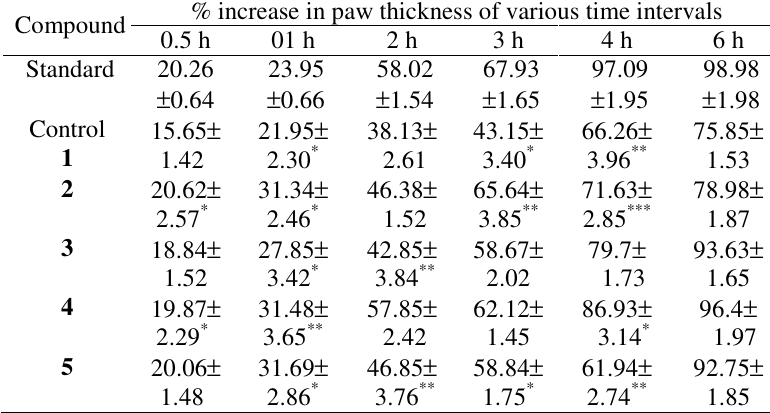
Table 3. Anti-inflammatory activity of the compounds ( 1-5